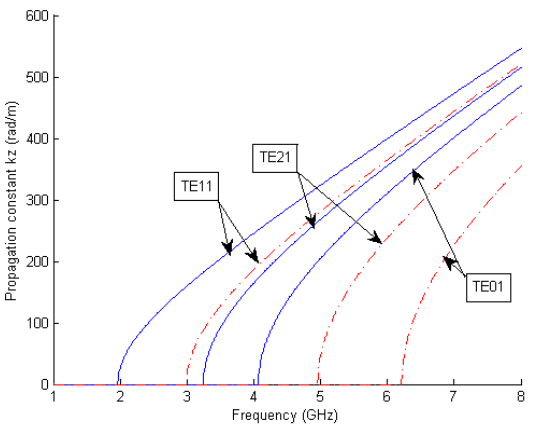
Figure 4. Curves of the propagation constant k TE z for the first three transverse electric (TE) modes of the cylindrical waveguide completely filled with LMF. _____ : case for a demagnetized ferrite. _._._._._. : case for M M S